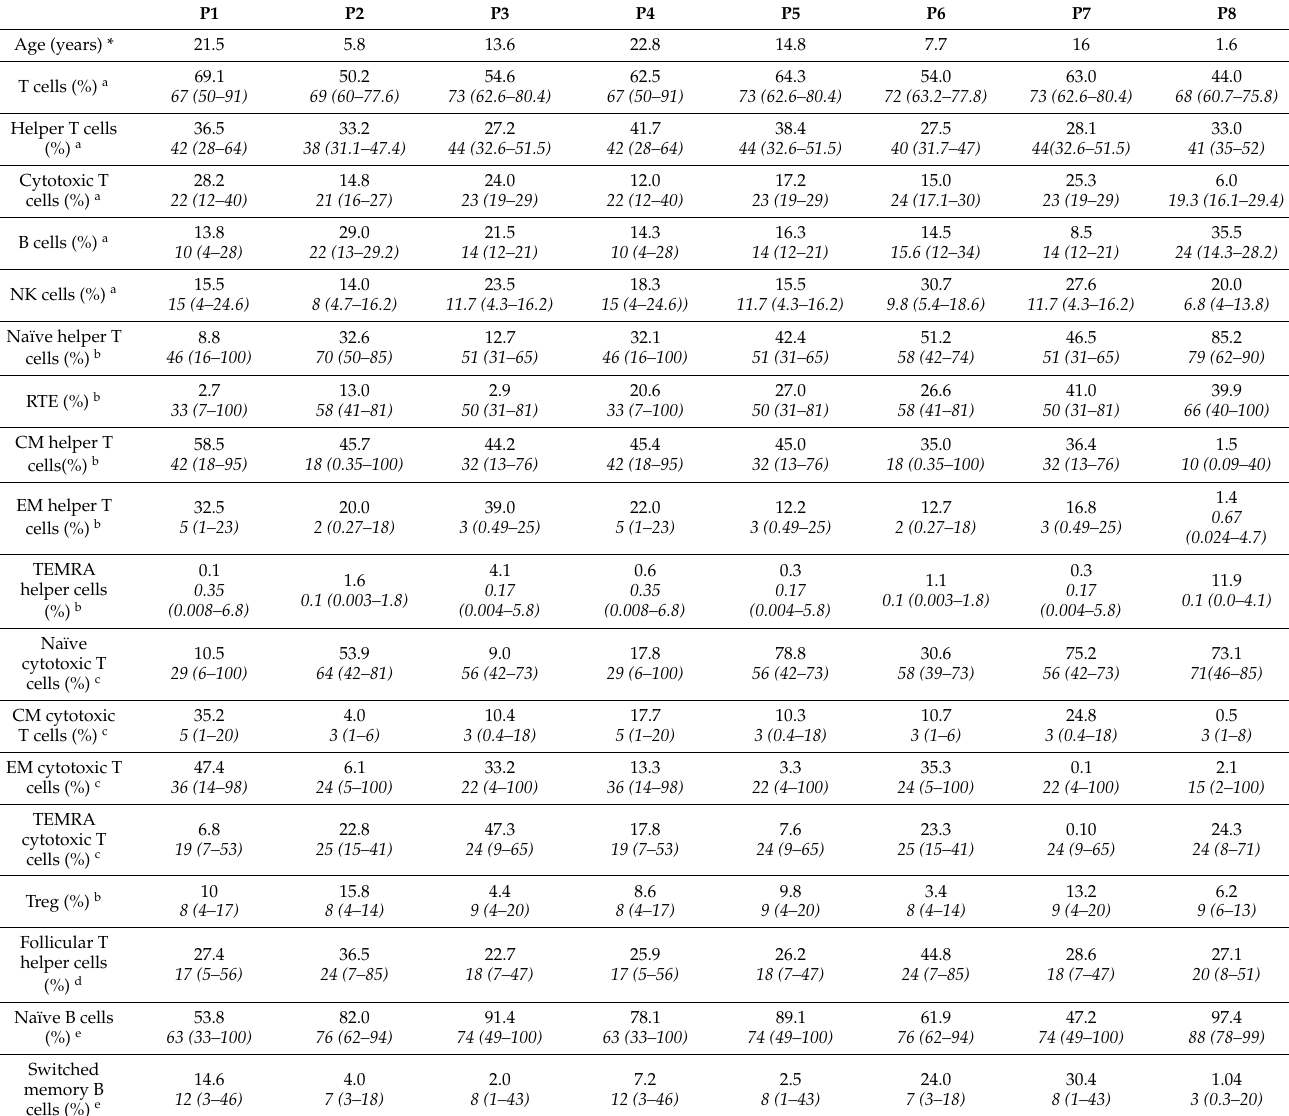
Table 3. Advanced phenotypes of the